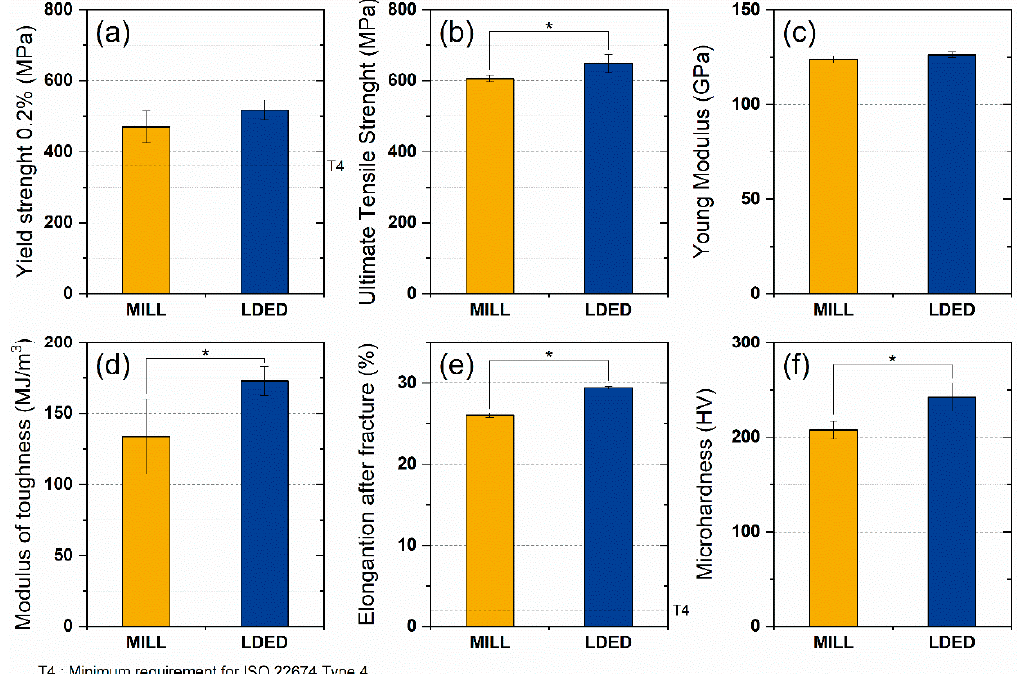
Figure 9. Mechanical properties of MILL and LDED materials: yield strength ( a ), ultimate tensile strength ( b ), Young’s modulus ( c ), modulus of toughness ( d ), elongation after fracture ( e ), and microhardness ( f ). Error bars indicate the standard deviation. Asterisks (*) mean a level of significance p < 0.05.